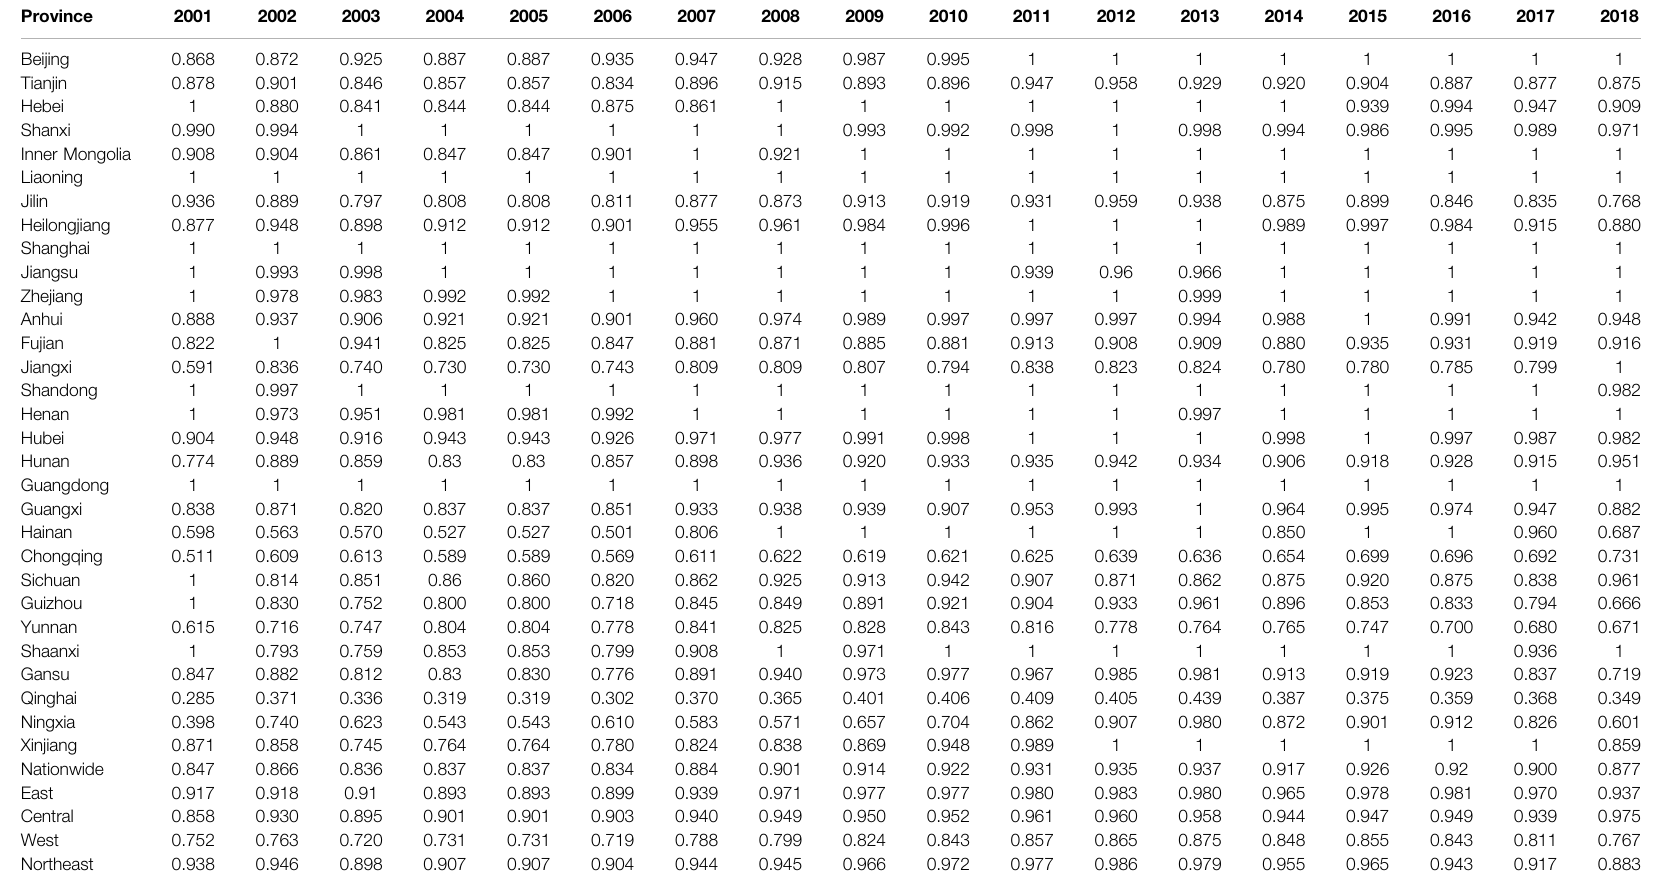
TABLE 3 | Green total productivity of province from 2001 to 2018.